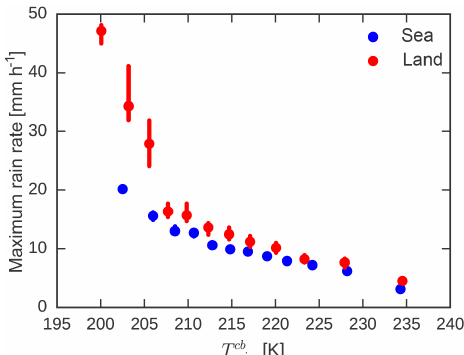
Figure 10. Median and standard error of maximum convective core rain rate as a function of minimum temperature within the convec- tive core for mature single-core systems separately over land (red) and ocean (blue) (AIRS and AMSR-E data,